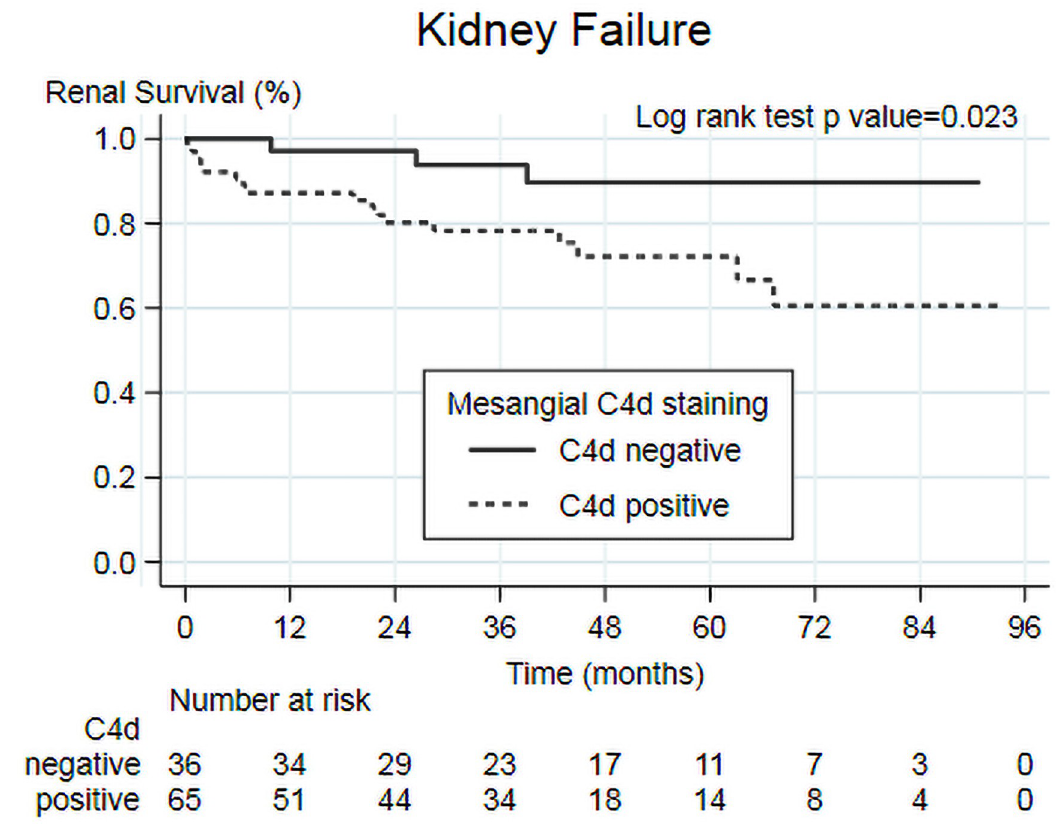
Fig 4. Kaplan-Meier analysis of mesangial C4d staining (positive vs negative) on secondary outcome (Kidney Failure).